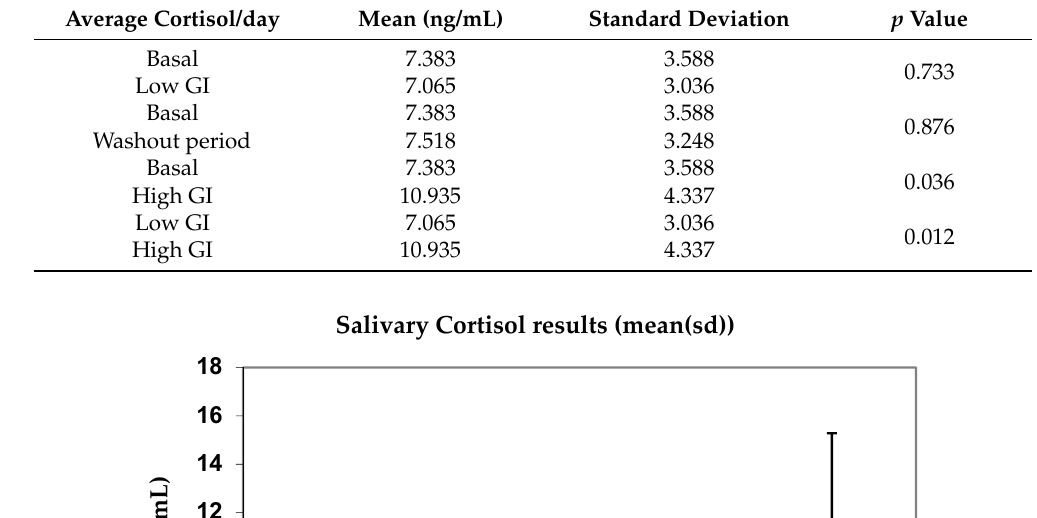
Figure 1. Testosterone concentration for basal, after low-GI diet, washout period and high-GI diet. Table 2. Cortisol values of basal, low GI, washout and high-GI cortisol.